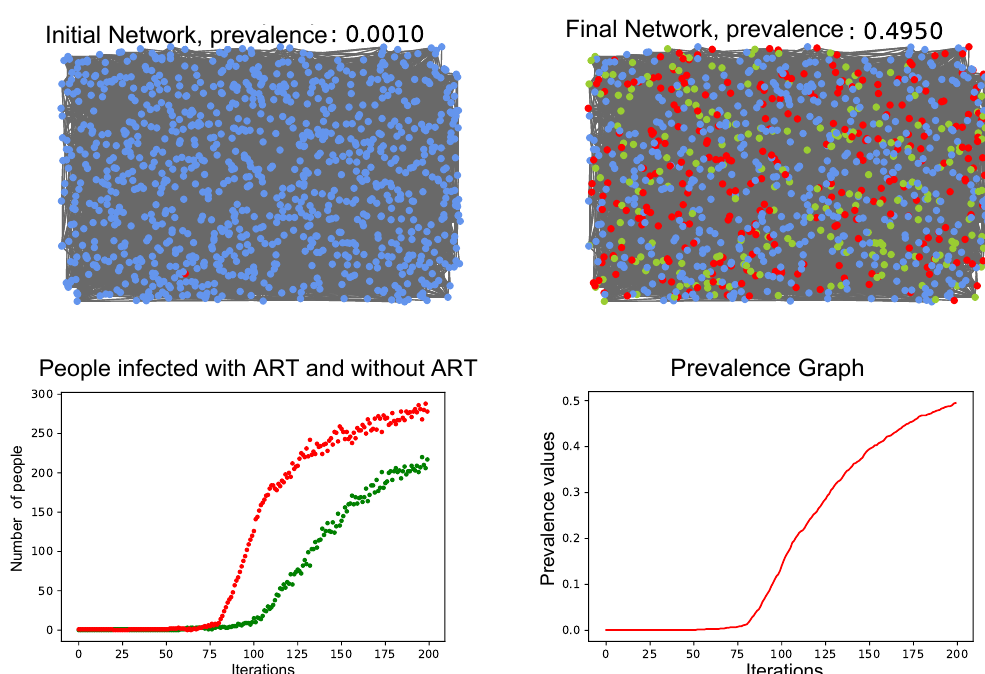
Figure 10. Upper : Simulation of the complex network for N T = 1000, τ = 200, γ = 3.4, and k = 10 (Blue: susceptible individuals. Red: carriers without ART. Green: carriers with ART). Lower left : Graphic showing the relation between people infected with and without ART. Lower right : Graphic of virus prevalence over time τ . The scenario shown does not seek to represent reality, it only aims to illustrate the operation of the coupled